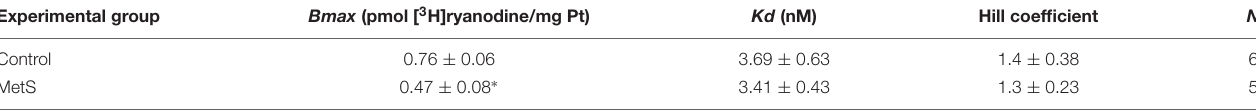
TABLE 2 | Parameters of saturation [ 3 H]-ryanodine binding curves in microsomes of MetS and control hearts. Experimental group